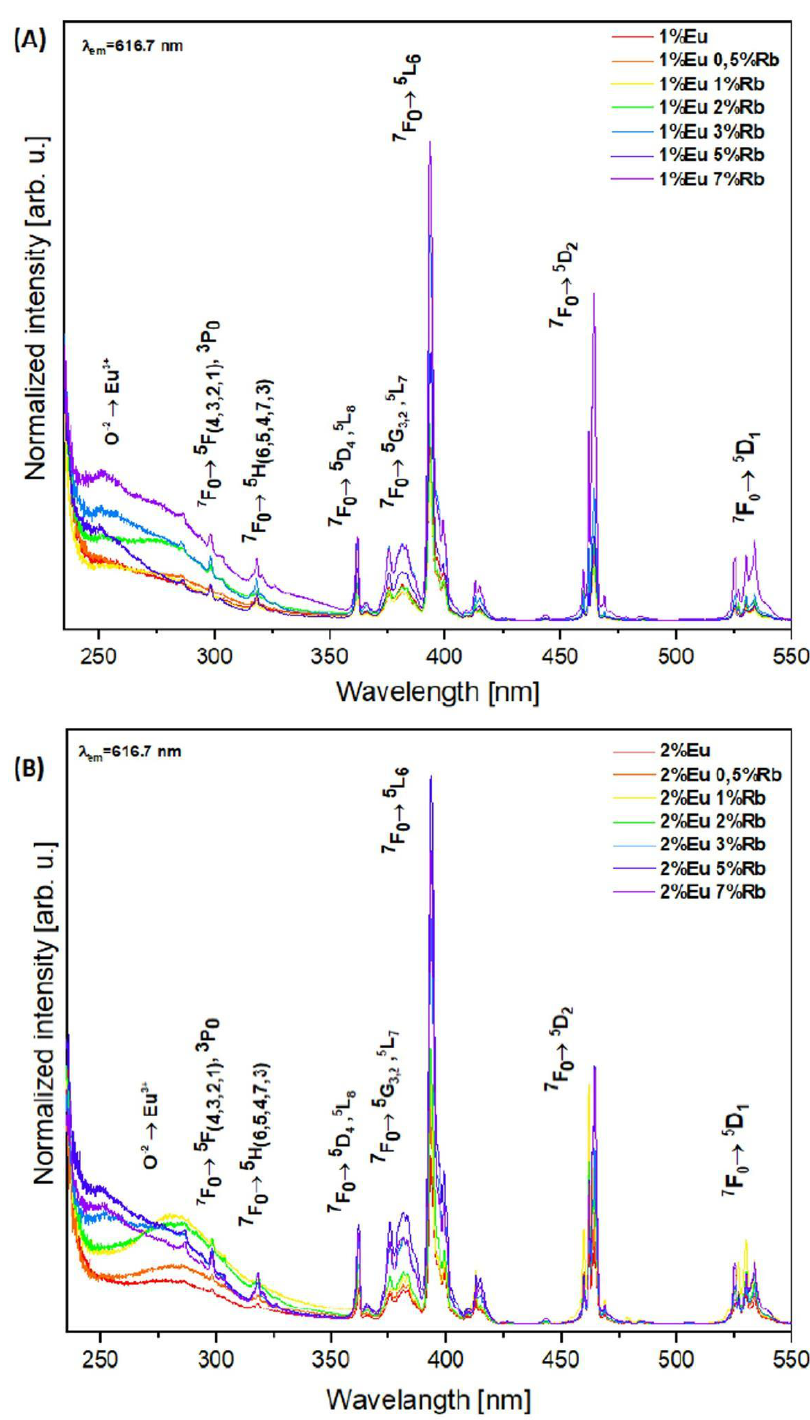
Figure 6. Excitation spectra of ( A ) Ca 10 − (0.1 + x) Eu 0.1 Rb x (PO 4 ) 6 (OH) 2 and ( B ) Ca 10 − (0.2 + x) Eu 0.2 Rb x (PO 4 ) 6 (OH) 2 , where x equals 0.5, 1, 2, 3, 5, 7 mol% of Rb + ions. To evaluate the influence of Rb + ions on the fluorescence lifetime and luminescence kinetics of Eu 3+ doped hydroxyapatite materials, the luminescence decay profiles were recorded for both series of materials (Figure 7A,B). The luminescence kinetics for both series showed strong correlation between the lifetime of Eu 3+ ions and the concentration of co-doped Rb + ions in the hydroxyapatite crystal lattice (Figure 7A,B). It should be noted that among samples containing 1 mol% of Eu 3+ ions, increasing concentrations of